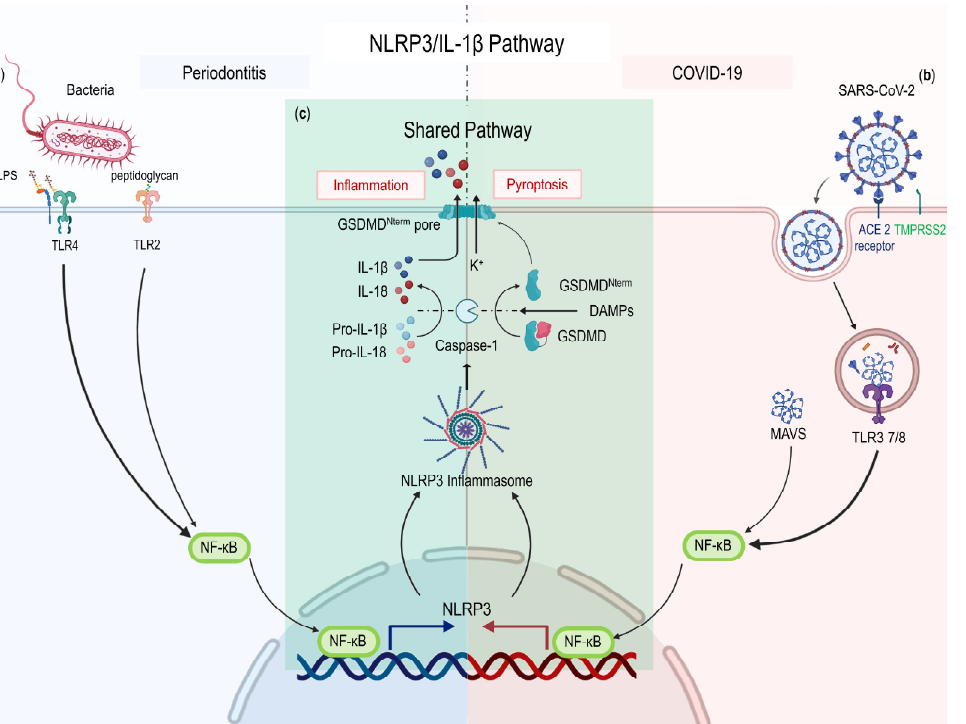
Figure 2. The NLRP3/IL-1β pathway in periodontitis and COVID-19. ( a ) Components of periodontitis pathogens (LPS and peptidoglycan) activate TLR4/NF-κB and TLR2/NF-κB pathway, respectively. ( b ) SARS-CoV-2 bind to ACE2 receptor or TMPRSS2 to entry cell and activate TLR3 or 7/8 and MAVS. Then, these receptors activate NF-κB signaling. ( c ) NLRP3/IL-1β pathway (Shared pathway). NF-κB triggered NLRP3 inflammasome. Caspase 1 is activated during inflammasome formation, and it then cleave pro-IL-1β, pro-IL-18, and GSDMD. Eventually, the release of IL-1β, IL- 18, and GSDMD induce inflammation and pyroptosis. Legend. ACE2, angiotensin receptor 2; GSDMD, Gasdermin D; GSDMDNterm, GSDMD amino-terminal cell death domain; LPS, lipopolysaccharide; MAVS, Mitochondrial Antiviral Signaling Protein; SARS-CoV-2, severe acute respiratory syndrome coronavirus-2; TLR, Toll-like receptor; TMPRSS2, Transmembrane Serine Protease 2.